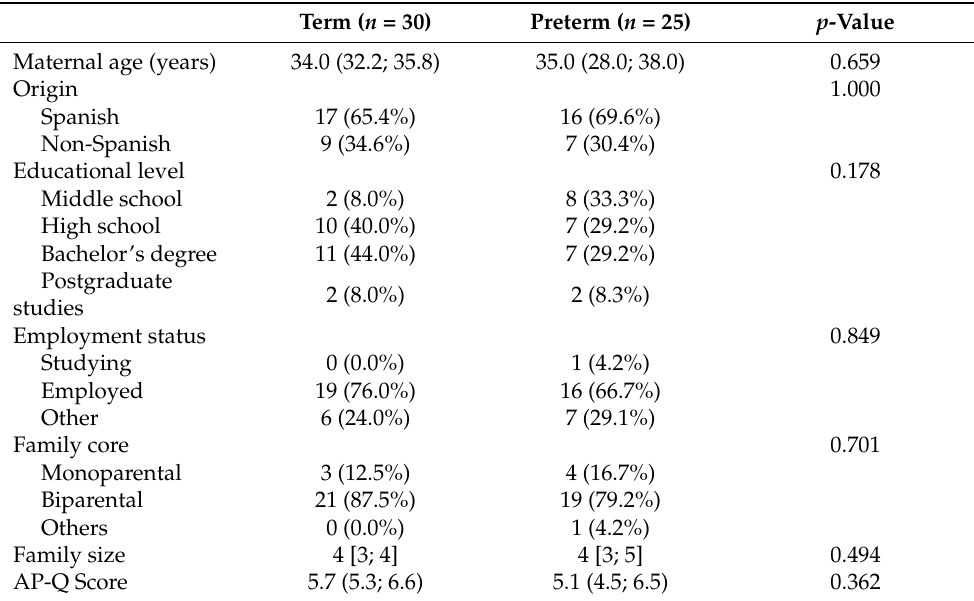
Table 1. Sociodemographic characteristics and AP-Q score between women with term and preterm